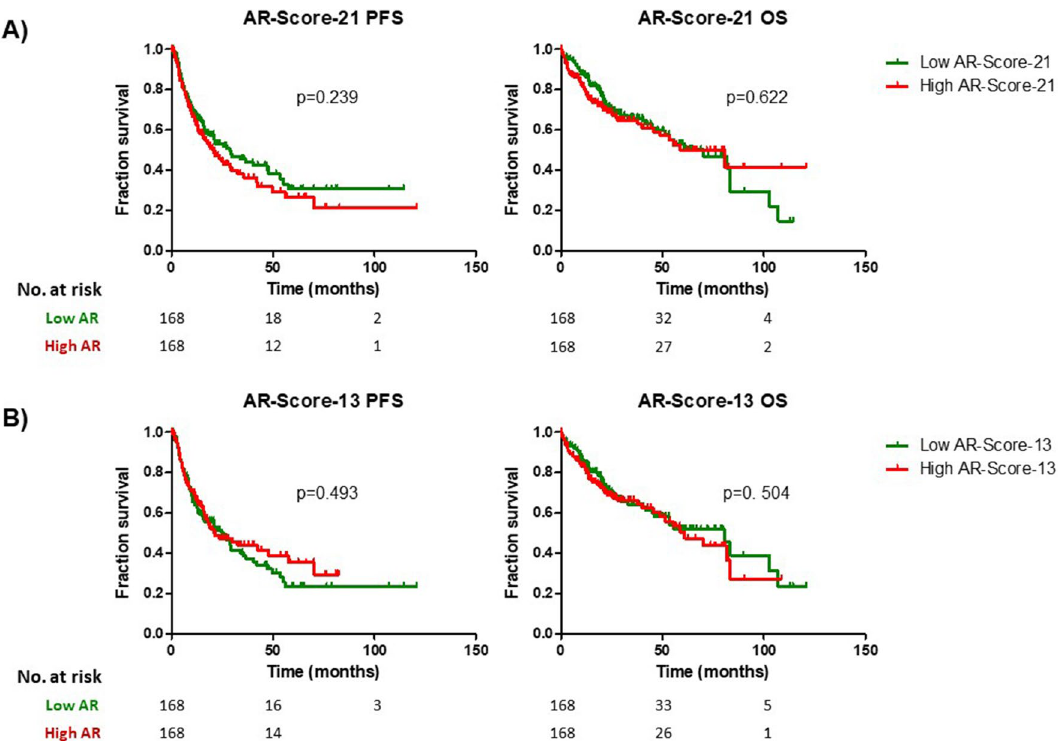
Figure 3. Survival analysis (progression free survival [PFS] and overall survival [OS]) in different AR-Score-21 ( A ) and AR-Score-13 groups ( B